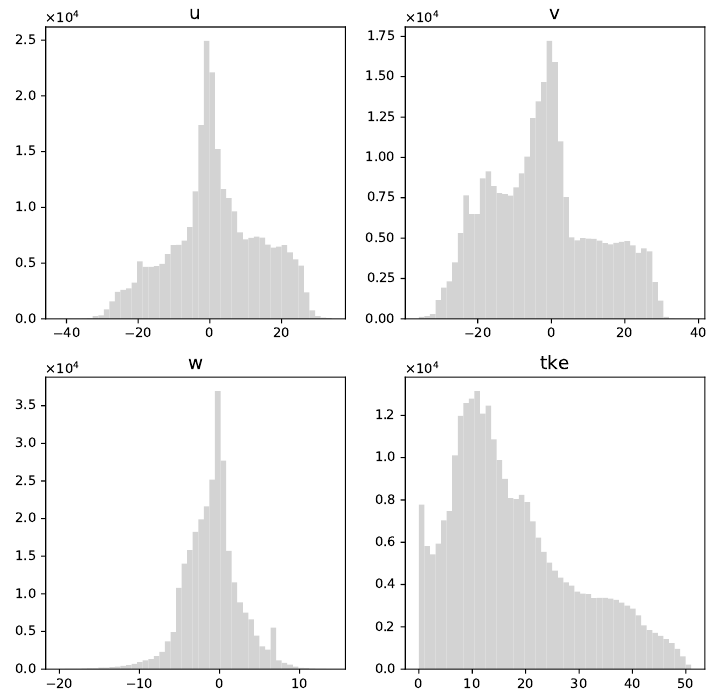
Figure 3. Distribution of variables in each input data column.